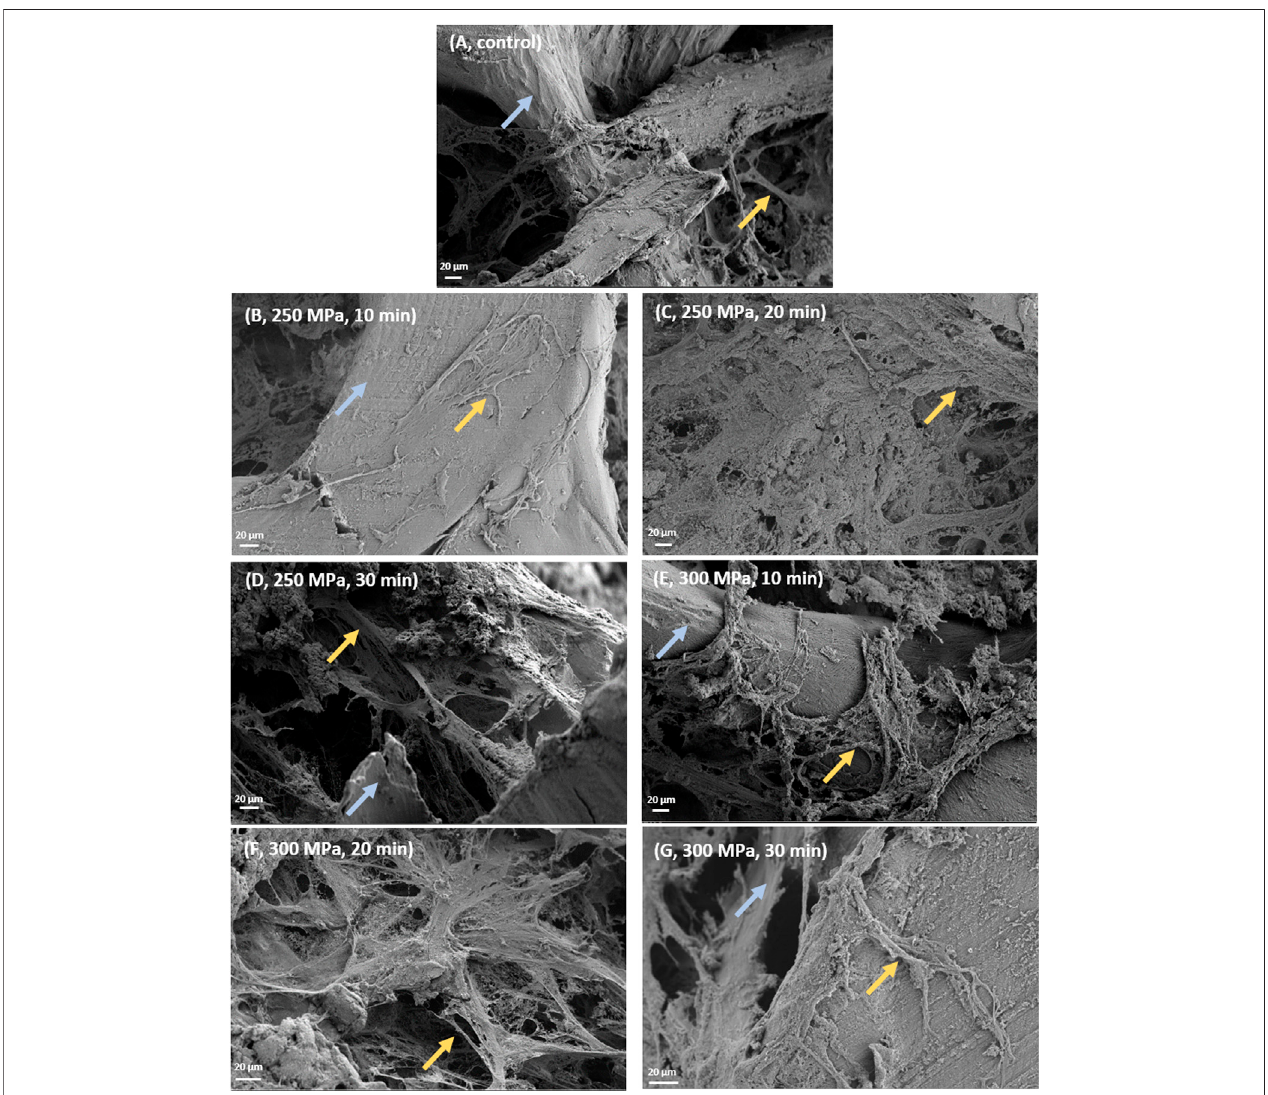
FIGURE 8 | Scanning electron microscopy of human trabecular bone following HHP-treatment. (A) untreated control, magni fi cation × 239; (B) 250 MPa, 10 min, magni fi cation × 283; (C) 300 MPa, 10 min, magni fi cation × 246; (D) 250 MPa, 20 min, magni fi cation × 237; (E) 300 MPa, 20 min, magni fi cation × 282; (F) 250 MPa, 30 min, magni fi cation × 280; (G) 300 MPa, 30 min, magni fi cation × 415. Blue arrows tag trabeculae, yellow arrows highlight cellular